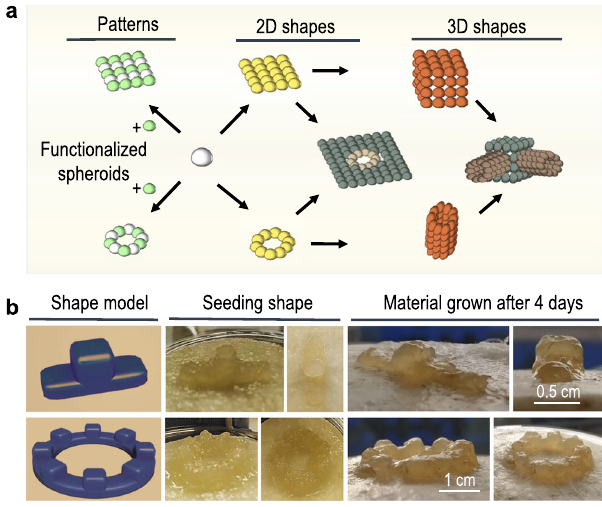
Fig. 2 BC spheroids as 3D building blocks. a Schematic of potential 2D and 3D structures that can be built from spherical building blocks. b Growth of two example 3D shapes constructed using BC spheroids (see Supplementary Materials for further examples). Model of desired structure (left), the seeded spheroid shape assembled manually (middle) and the resultant material structure produced after 4 days of further growth